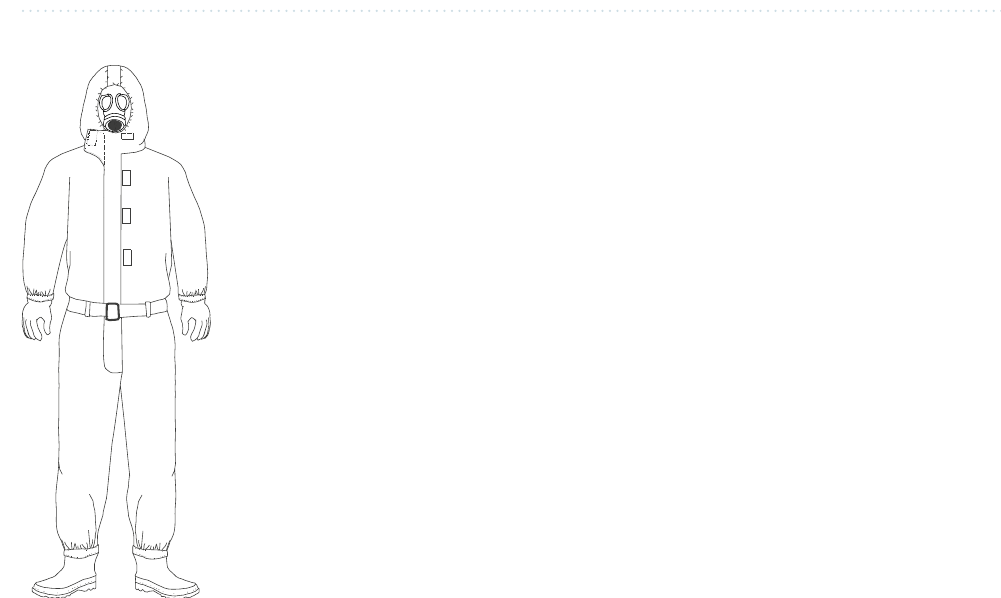
Table 1. Numbers and locations of 35 sweat pads for the upper body.